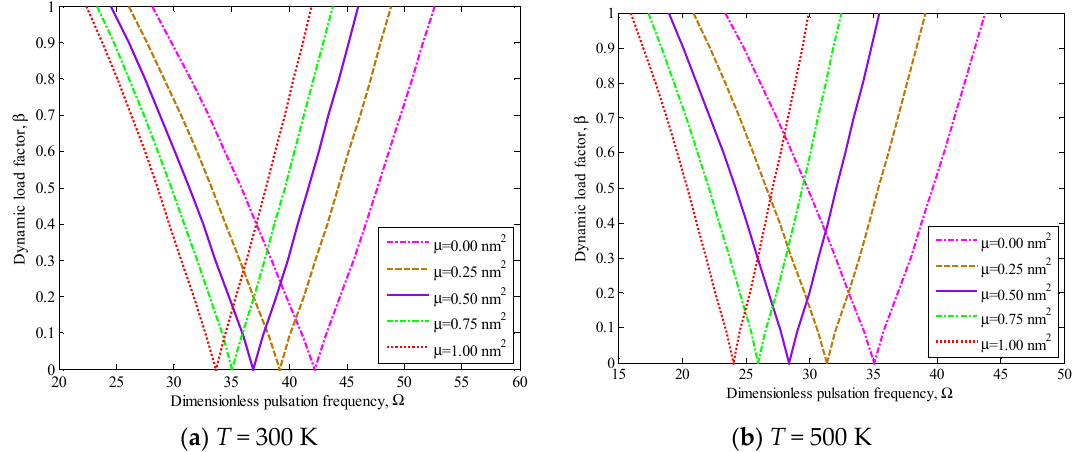
Figure 6. Effect of the NP on the DIR of the SLGS resting on an elastomeric foundation.